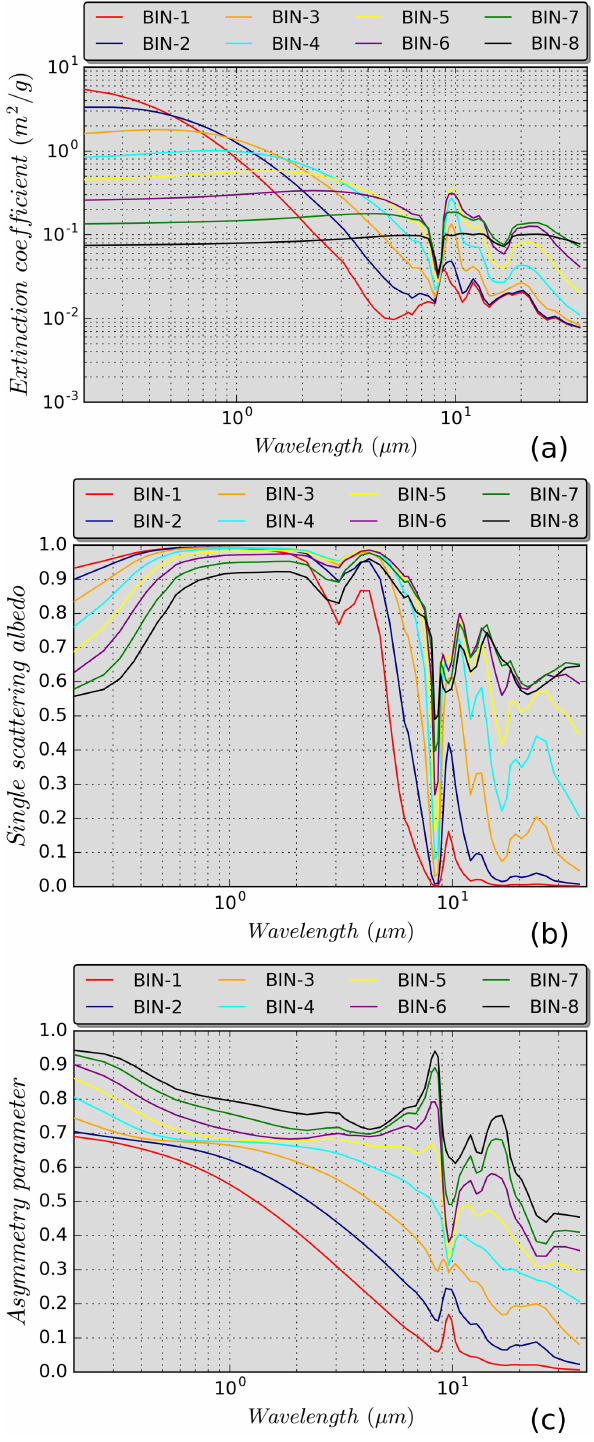
Figure 2. Spectral variation of the GOCART: (a) extinction coef- ficient (in m 2 g − 1 ), (b) single scattering albedo and (c) asymmetry parameter, for each one of the eight dust bins which are considered in the dust